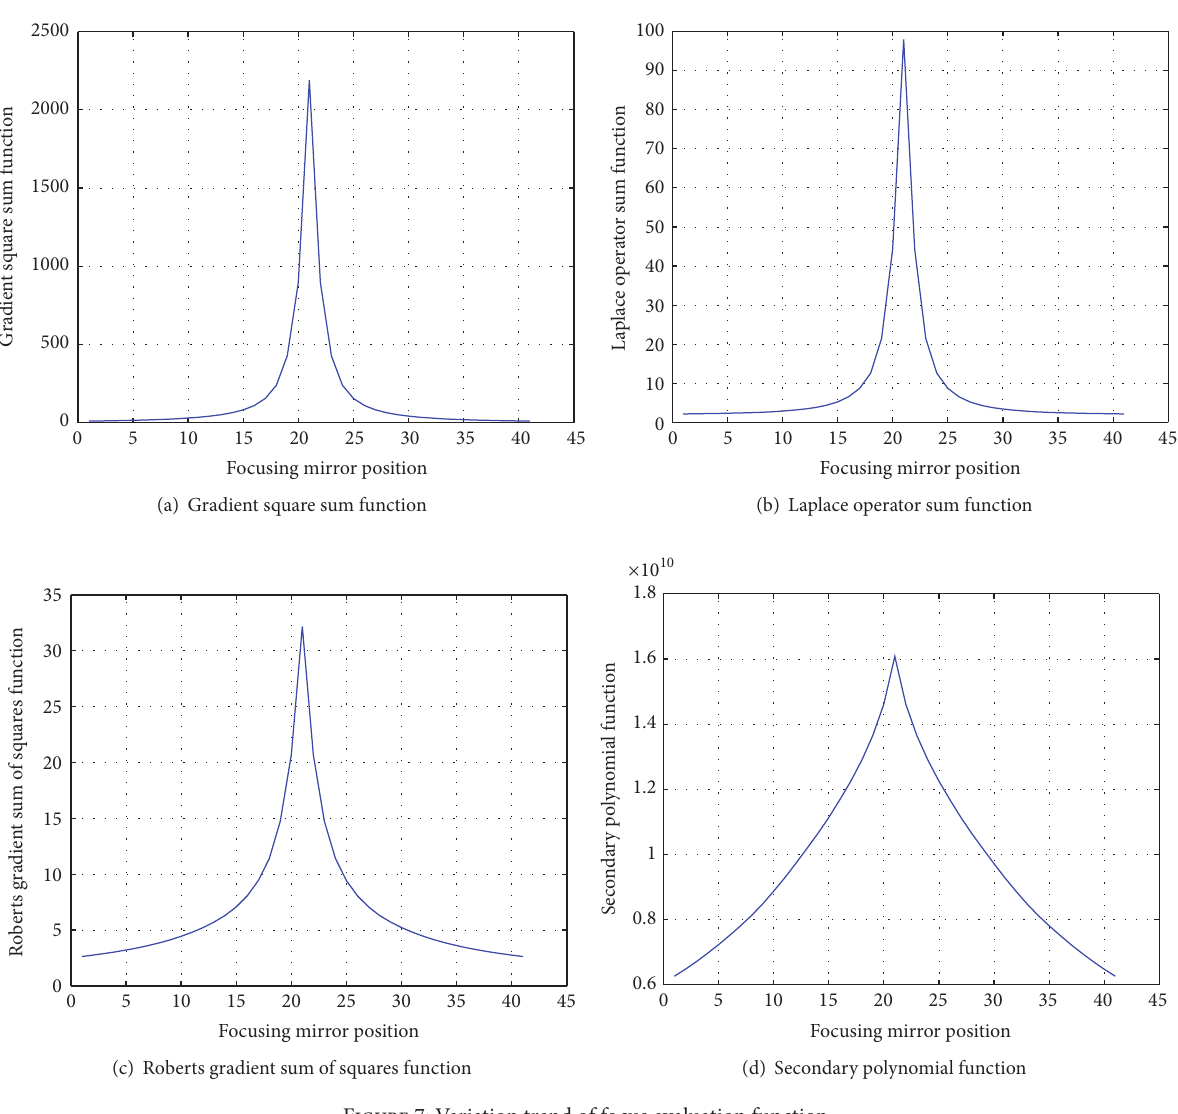
Figure 7: Variation trend of focus evaluation